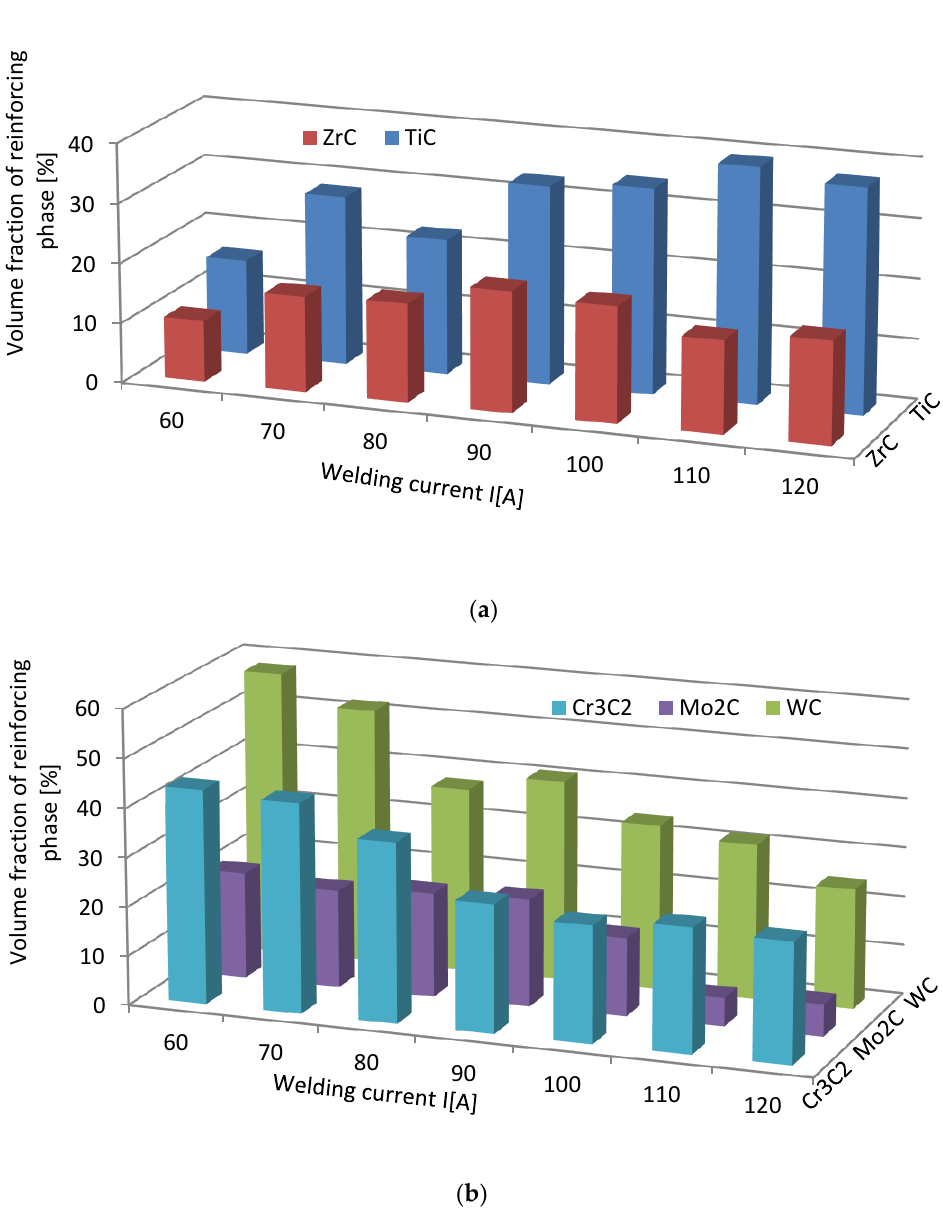
Figure 19. Impact of welding current on the volume fraction of the strengthening phase in overlays with TMs carbides of IVB ( a ) and VIB groups ( b ).